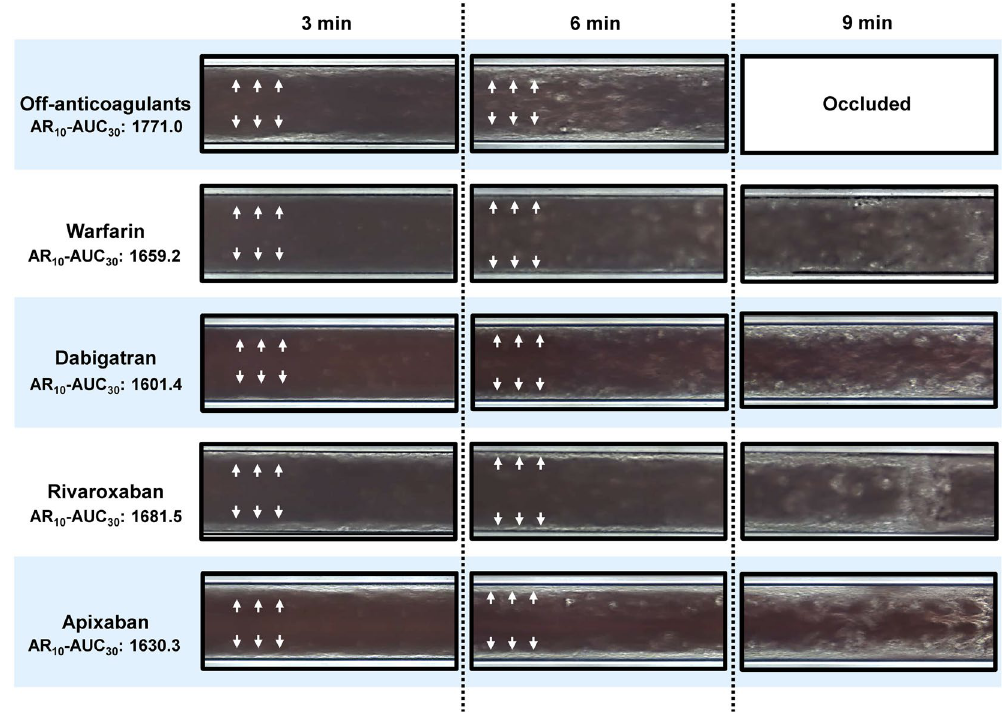
Figure 2. Light microscope images of the AR-chip. Representative microscopic images of thrombus formation under flow condition in Off-anticoagulants, warfarin, and DOAC